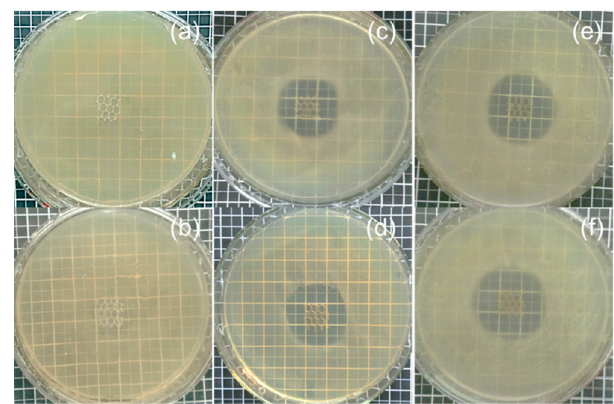
Figure 7. Antibacterial activity by inhibition zone: ( a , b ) PP control, ( c , d ) low molecular weight chitosan and levofloxacin-coated, ( e , f ) medium molecular weight chitosan and levofloxacin HCl-coated. Note: the top row is SA and the bottom row is EC.